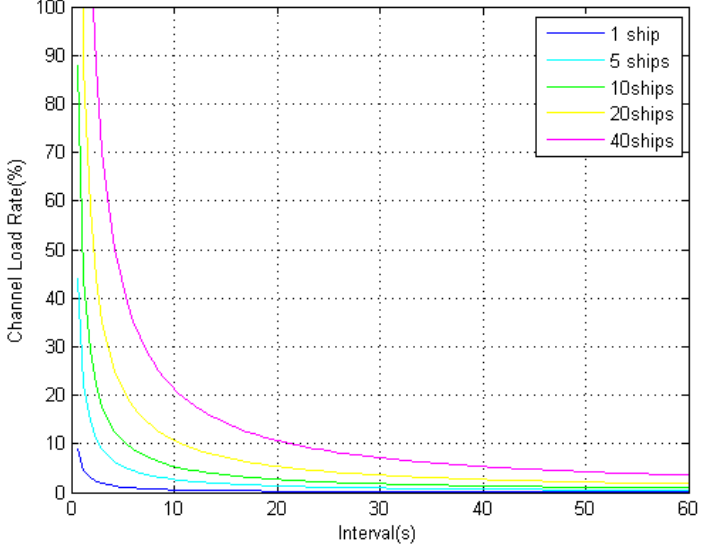
Figure 5. The channel load rate when using addressed binary